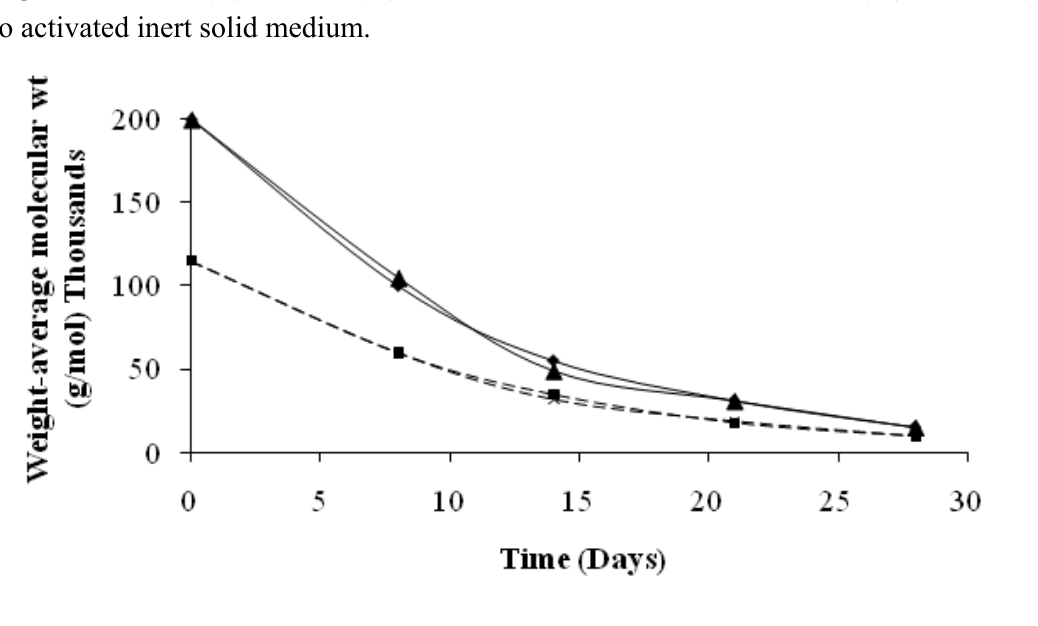
Figure 7. Evolution of the molecular weight of non-degraded PLA as a function of the ageing time for Mw ( (cid:141) ) and Mn ( (cid:132) ) in activated inert solid medium, Mw ( (cid:99) ) and Mn (x) in no activated inert solid